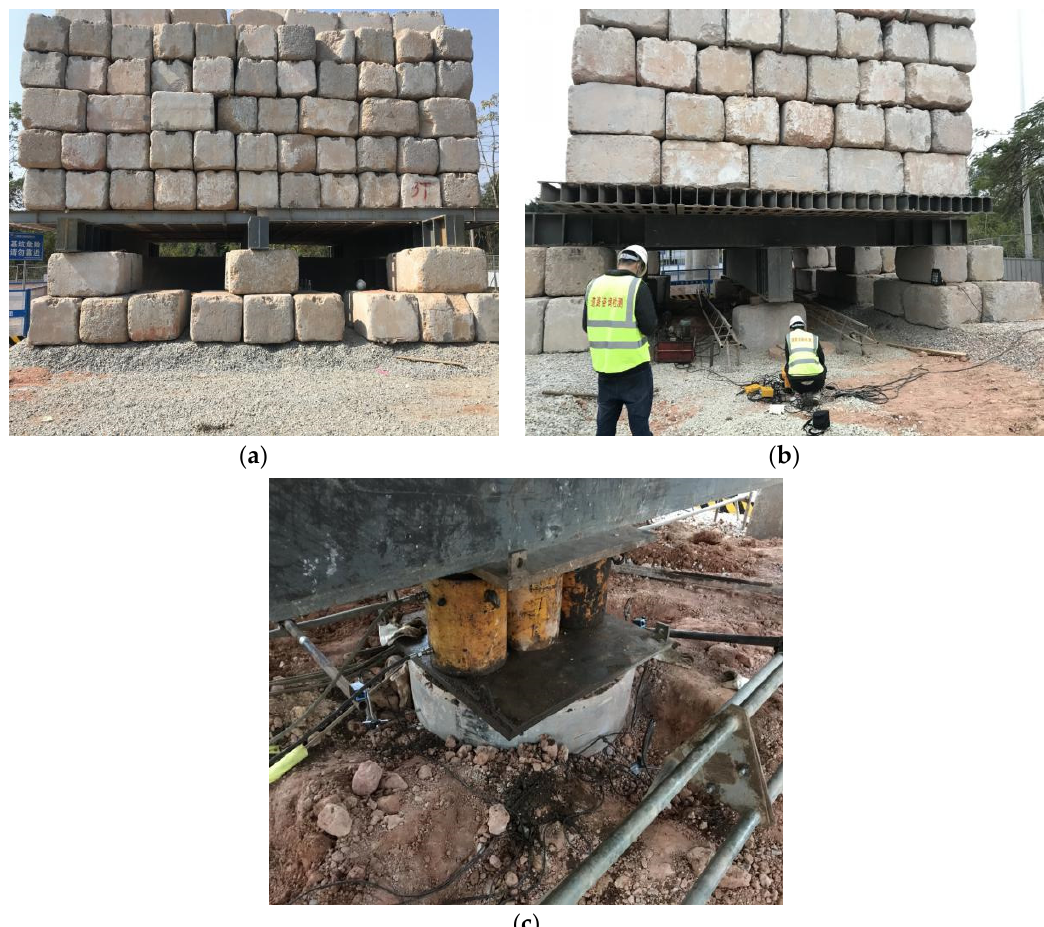
Figure 7. Field test of a vertical compressive static load of the single pile: ( a ) ballast platform; ( b ) field test; and ( c ) lifting jack and displacement sensor installation. Table 3. Loading and unloading capacity at all levels and oil pressure of lifting jack in a vertical compressive static load test.